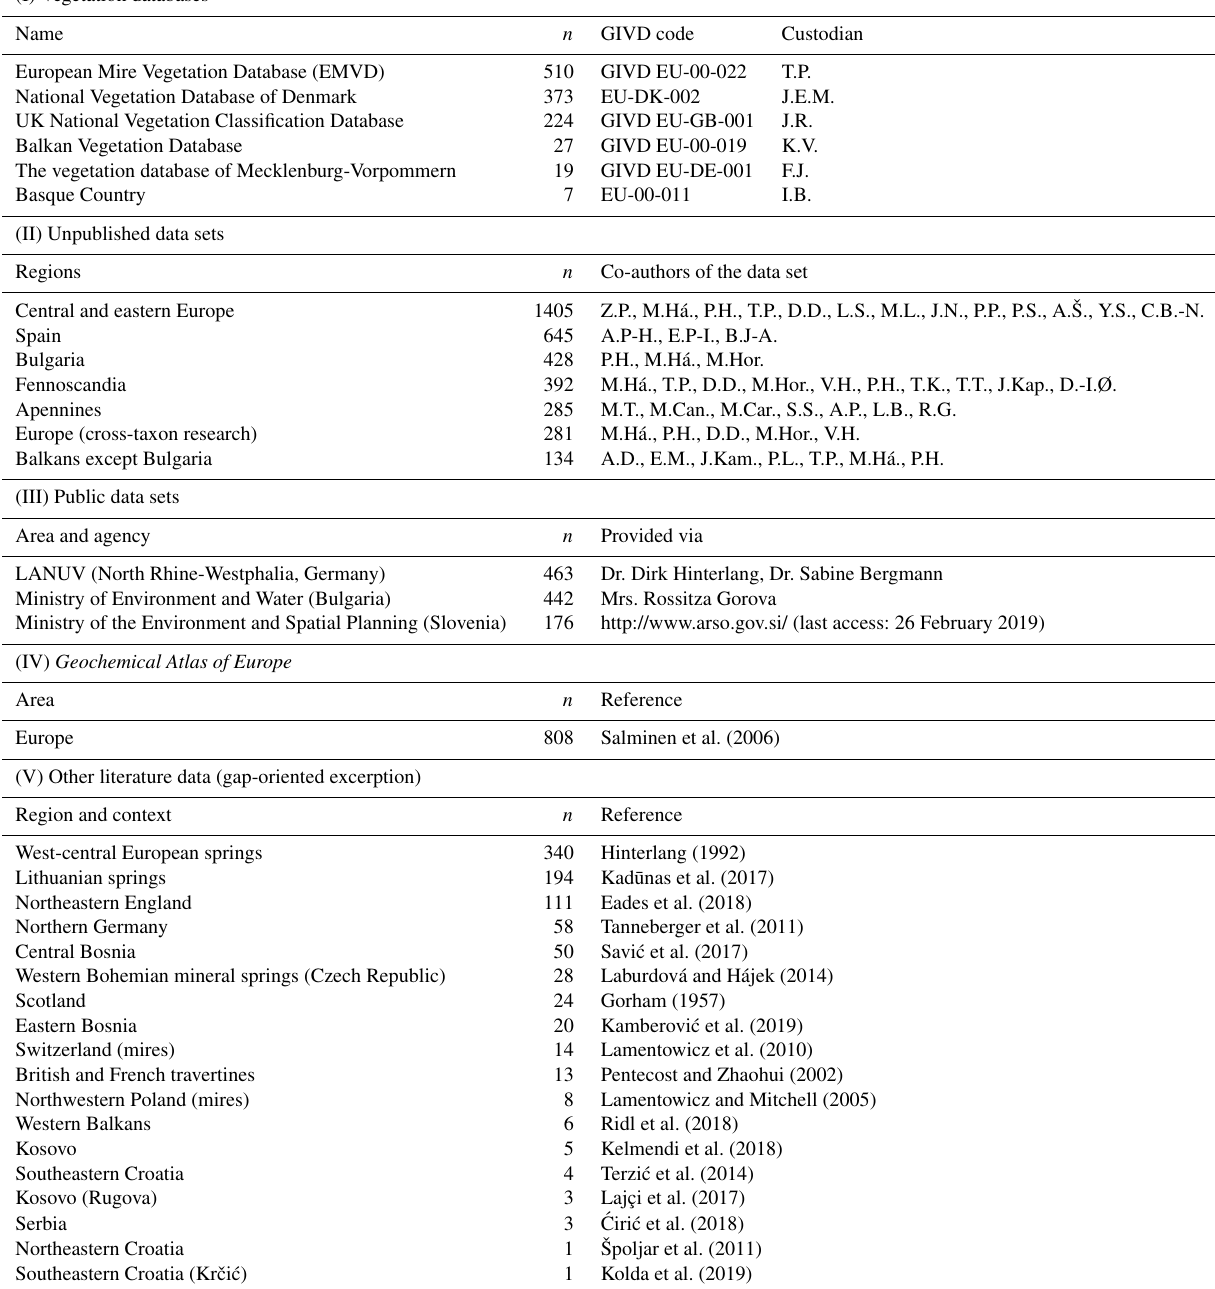
Table 1. Data sources. The name abbreviations are explained in the team list or Acknowledgements. LANUV: Landesamt für Natur, Umwelt und Verbraucherschutz Nordrhein-Westfalen (State Agency for Nature, Environment and Consumer Protection North